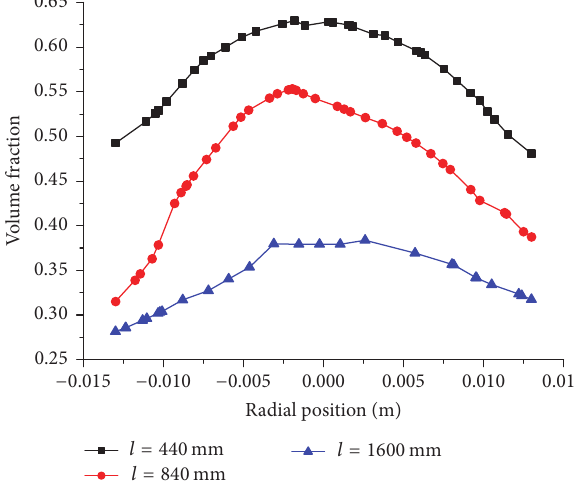
Figure 5: The gas volume fraction distribution on the cross section of the gas phase outlet.